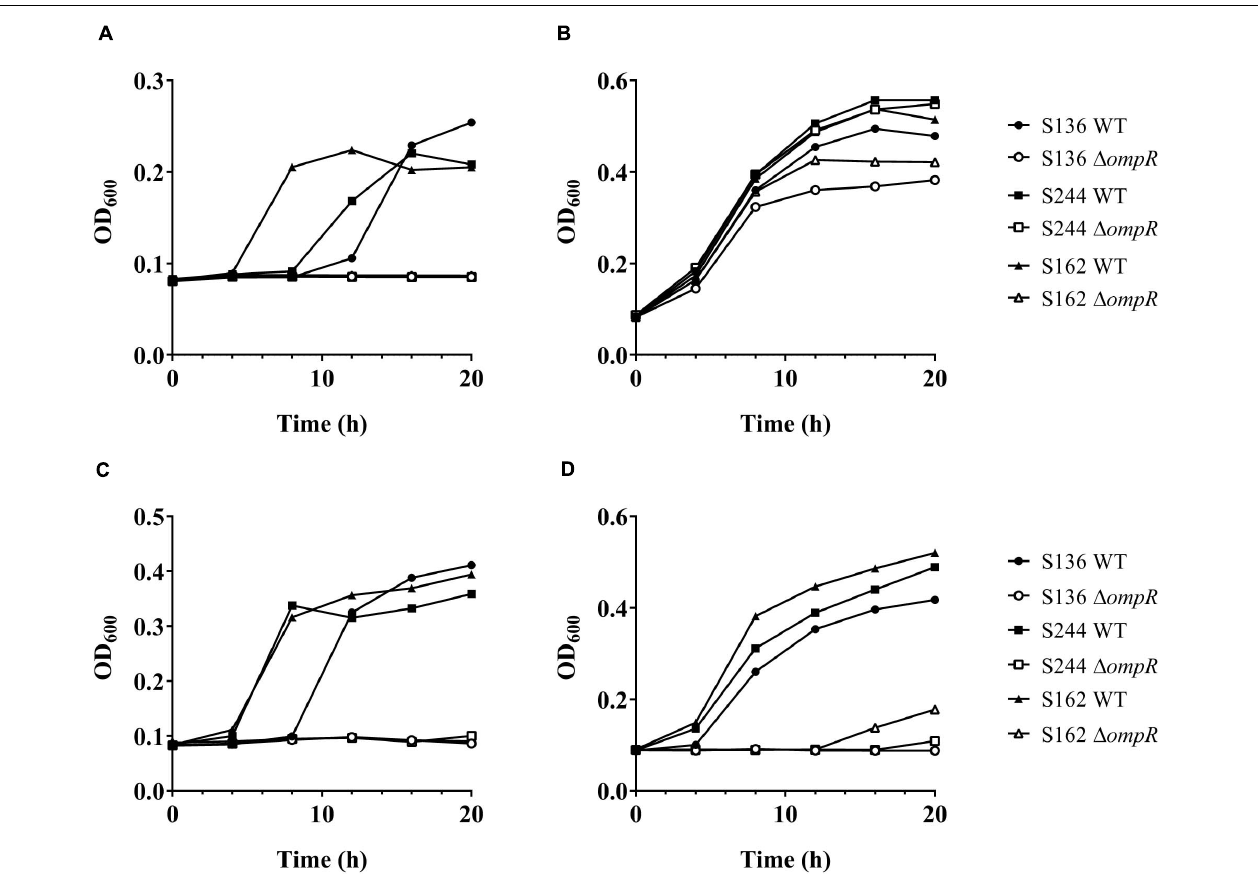
FIGURE 4 | Growth of AIEC WT and (cid:49) ompR mutants in presence of bile salts. The WT (filled symbols) AIEC strains S136 (circle), S244 (square), and S162 (triangle) and their (cid:49) ompR mutants (empty symbols) were grown in LB supplemented with (A) 0.5% bile salts, (B) 0.1% sodium cholate, (C) 0.1% DOC, and (D) 0.1% chenodeoxycholate. Data representative of at least two independent